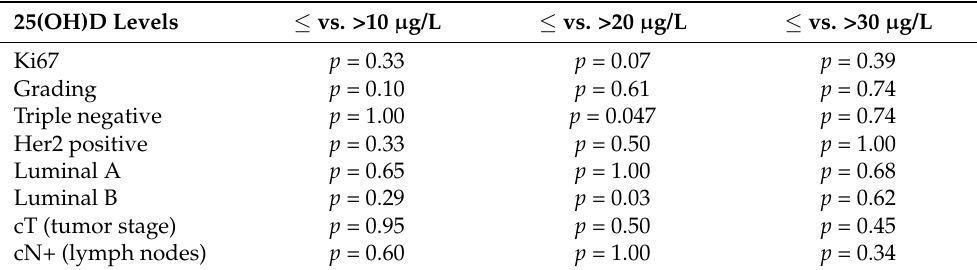
Table 8. Association of prognostic factors for breast cancer with serum 25-hydroxyvitamin D (25(OH)D) deficiency. The patients were divided into three groups: severe ( ≤ 10 µ g/mL: five patients versus >10 µ g/L: 103 patients), moderate ( ≤ 20 µ g/mL: 43 patients versus >20 µ g/L: 65 patients), and mild ( ≤ 30 µ g/mL: 74 patients versus >30 µ g/L: 34 patients) vitamin D